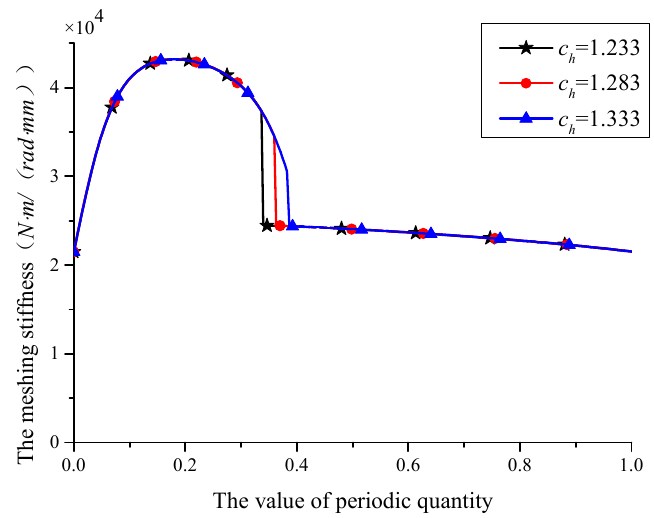
Figure 27. Influence rule of c h on meshing stiffness.